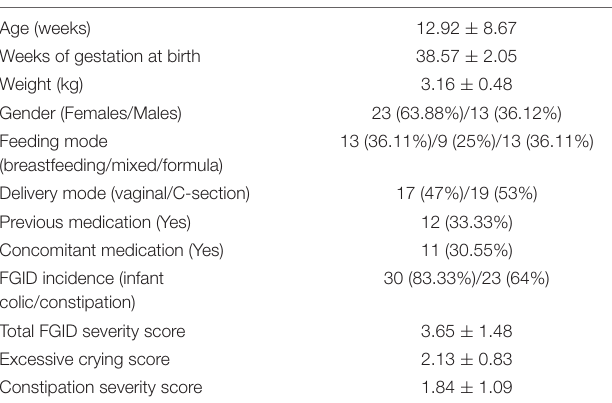
TABLE 3 | Demographic and clinical characteristics of recruited subjects ( n = 36) at enrollment and number of patients using concomitant medication during trial